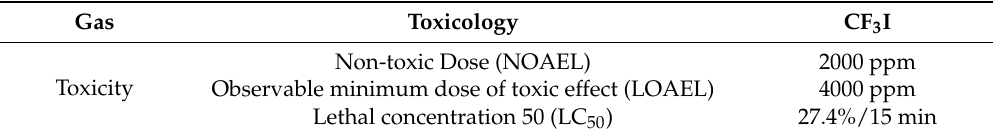
Table 8. Toxicological data for CF 3 I